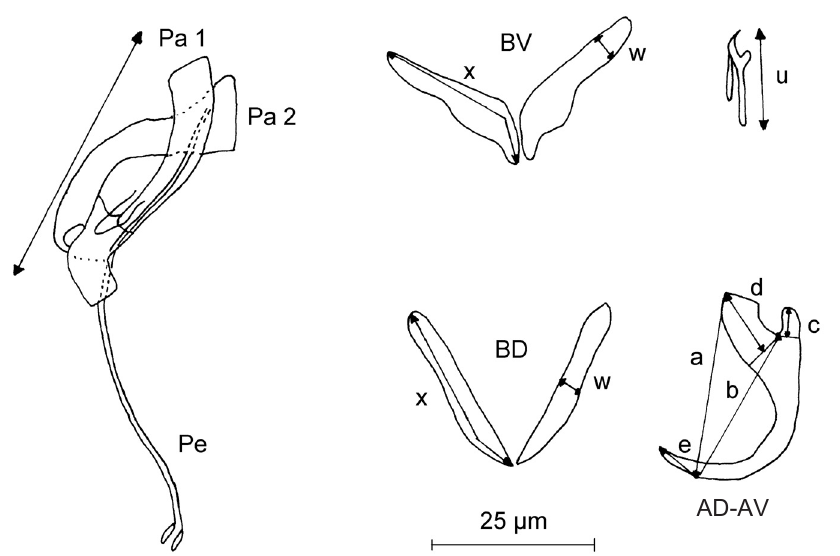
Fig. 1. – Mesures utilisées dans cette